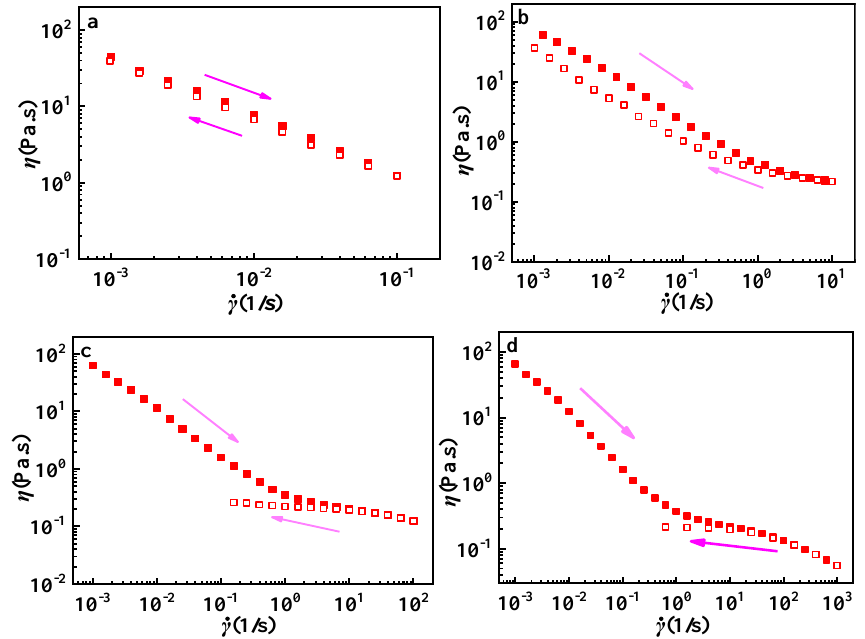
Figure 9. Shear and recovery rates of 10 mg/mL GPAM2 solutions with 0.01 M HAc in different limits of the upper shear rate of ( a ) 0.1 s − 1 , ( b ) 10 s − 1 , ( c ) 100 s − 1 , and ( d ) 1000 s − 1 , with a thermal treatment (holding at 60 °C for 15 min). All tests were conducted at 10 °C.